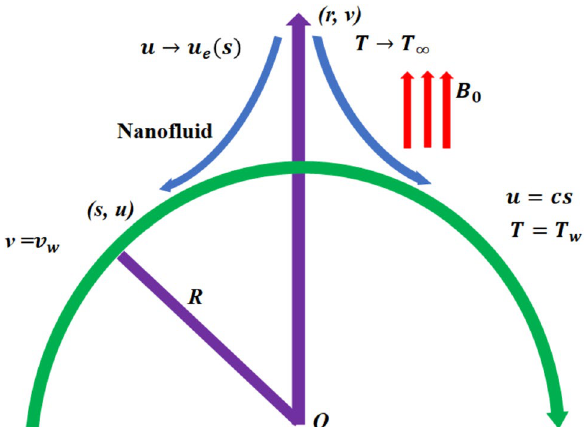
Figure 1. Geometry of the